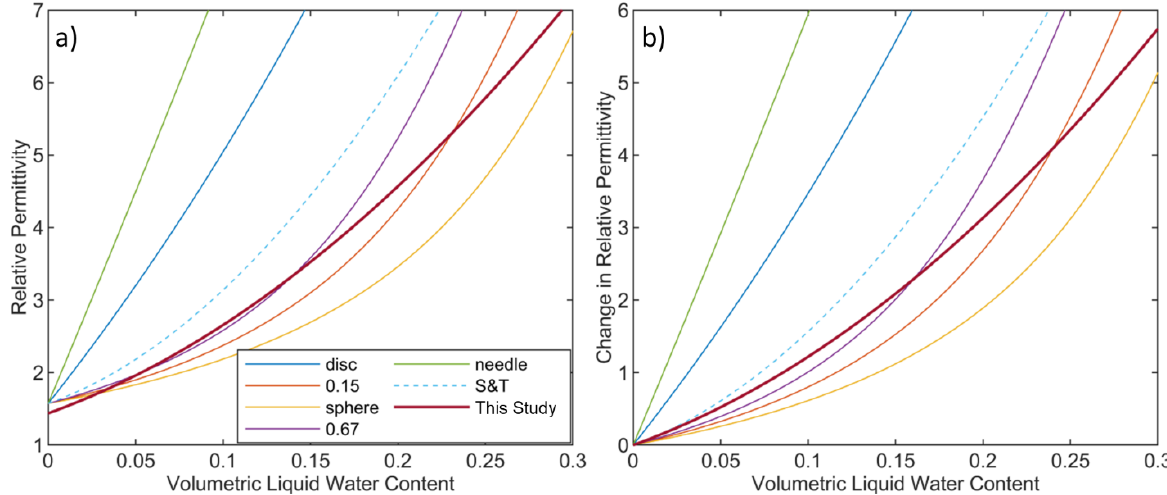
Figure 6. Comparison of relative permittivity equations based on the volumetric liquid water content of snow with a dry density of 300 kg m −3 . Equations shown are the Polder and van Santeen [29] formula for various shaped materials, Sihvola and Tiuri [31] (S and T), and the current study (This Study). Panel ( a ) shows the direct comparison of equations whereas panel ( b ) displays the relative change in permittivity for each equation as a function of the volumetric liquid water content.